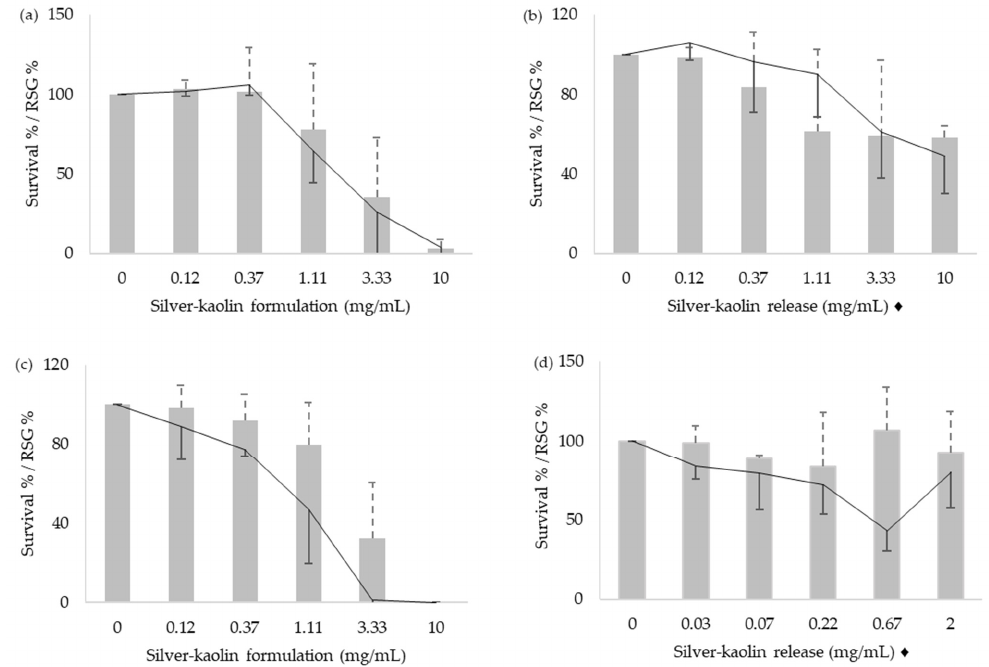
Figure 1. Results of the survival %, (bars with positive SD) and RSG % (lines with negative SD) of L5178Y TK +/ − cells. Cells were treated with the silver-kaolin formulation for 3 h ( a ), silver-kaolin release for 3 h ( b ), silver-kaolin formulation for 24 h ( c ), and silver-kaolin release for 24 h ( d ). Means and SD of three independent experiments are represented. ♦ The concentrations indicated correspond to the silver-kaolin formulation that was in agitation for 24 h (see Section 2.3).